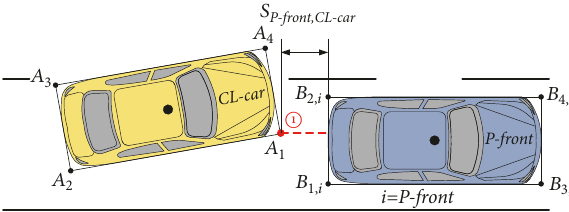
Figure 11: Actual distance